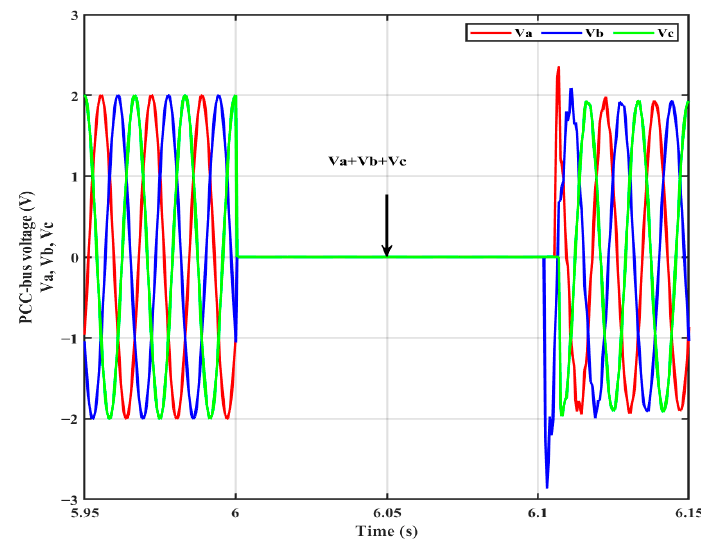
Figure 25. Voltage of PCC bus with LLLG fault.